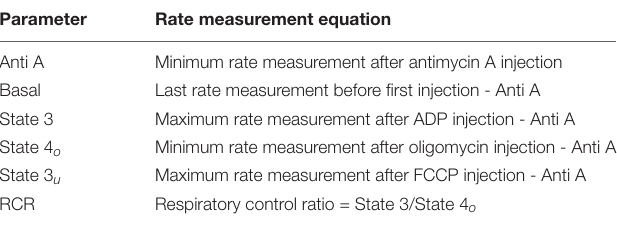
TABLE 1 | Seahorse parameter